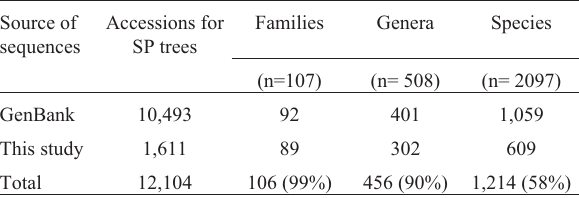
Table 1 - Number of sequences and taxa by source of information for the São Paulo tree flora, in respect to the ten DNA barcodes considered in this study. In parentheses, the proportion of each taxon with sequences avail- able for any of these ten barcodes. Source of Accessions for sequences SP trees